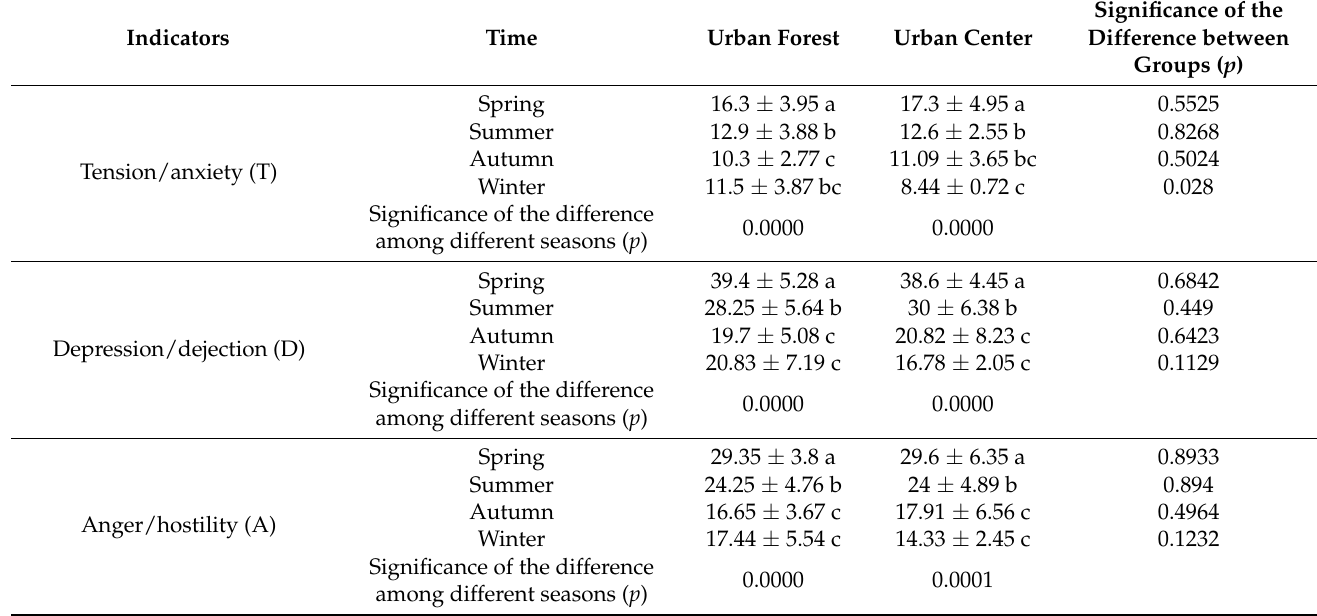
Table 5. Profile of mood state (POMS) evaluation of participants exposed to forest bathing and urban center environments in different seasons. Mean values ± standard deviation. Lowercase letters (a, b, c) in the same column indicate significant differences ( p < 0.05 using Kruskal–Wallis test) among different